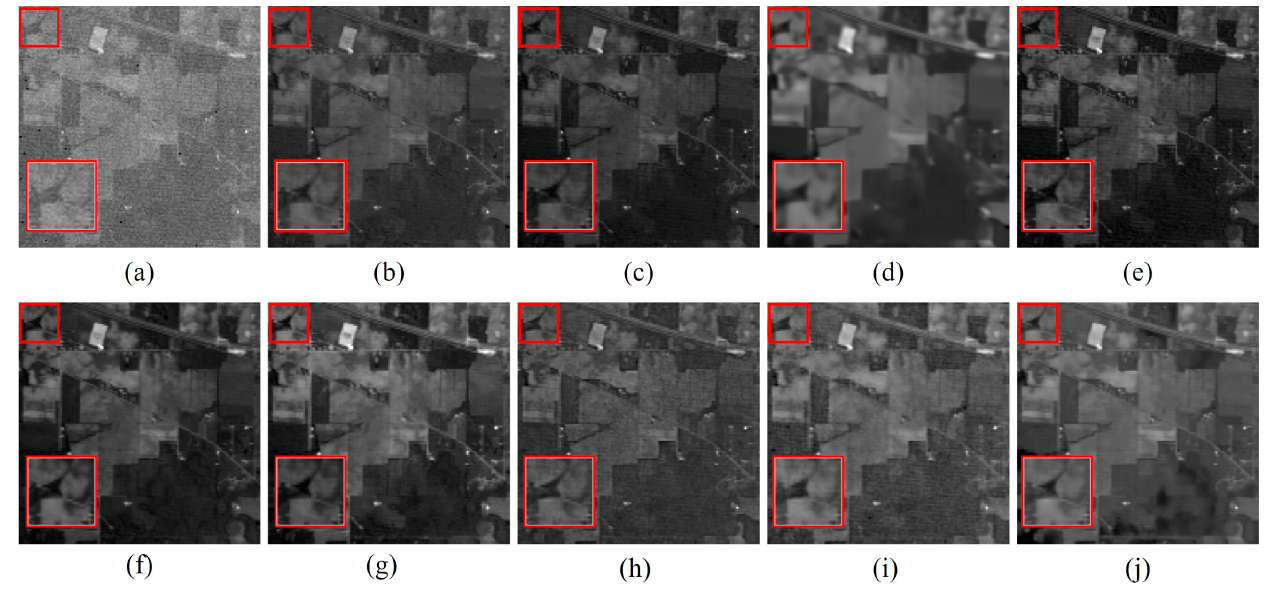
Figure 10. The denoised results on band 2 of the Indian Pines data. ( a ) Original; ( b ) LRMR; ( c ) NAILRMA; ( d ) NGmeet; ( e) L1HyMixDe; ( f) E3DTV; ( g ) LRTDTV; ( h ) HSI-DeNet; ( i ) HSID-CNN; ( j ) ours.